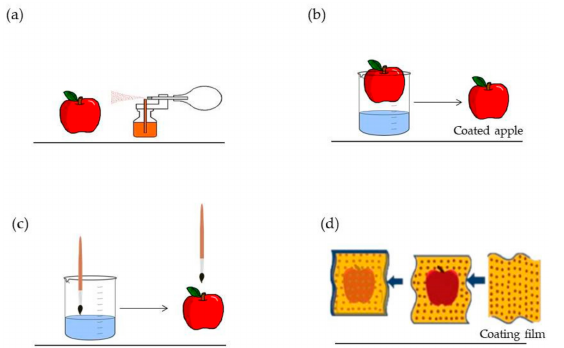
Figure 1. Schematic representation of coating techniques: ( a ) spraying; ( b ) dipping; ( c ) spreading and ( d ) wrapping (adapted from